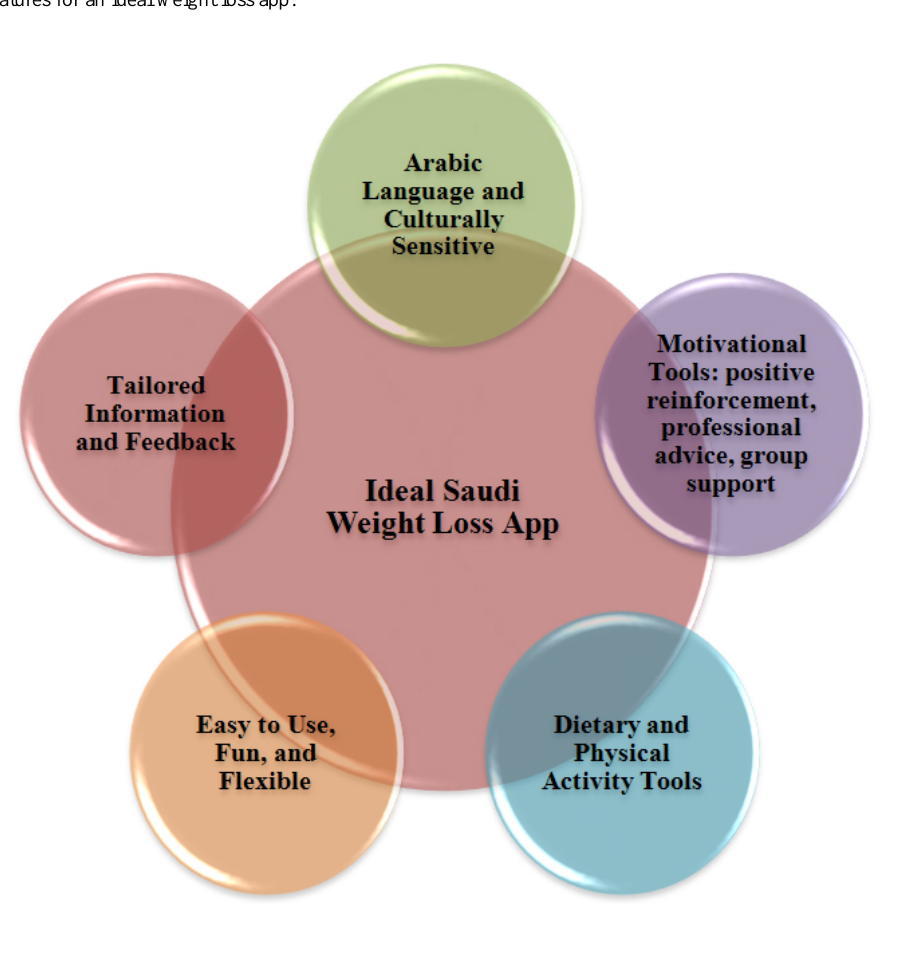
Figure 1. Proposed features for an ideal weight loss